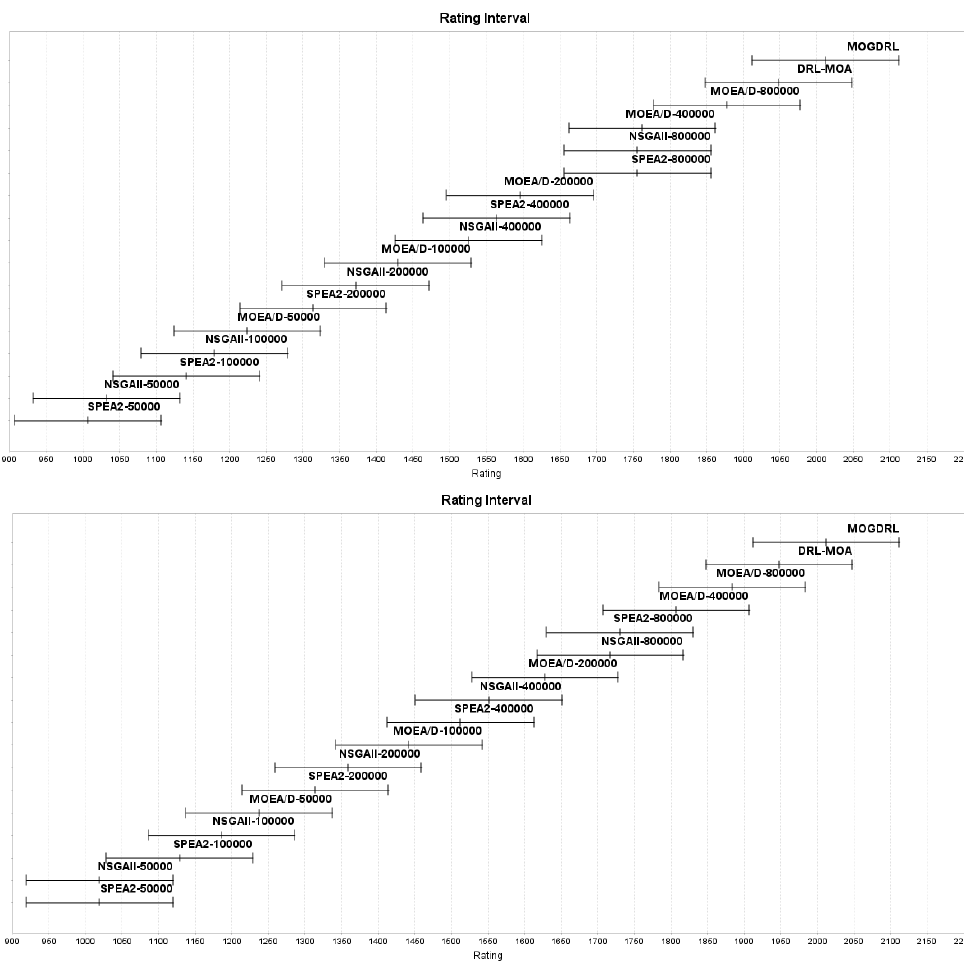
Figure A2. Hypervolume ranking results for 150 cities ( top row) and 200 cities ( bottom